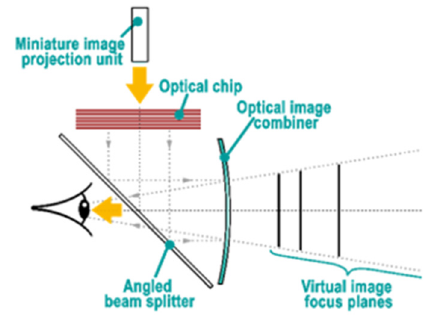
Figure 17. Principal layout of augmented reality headset system.